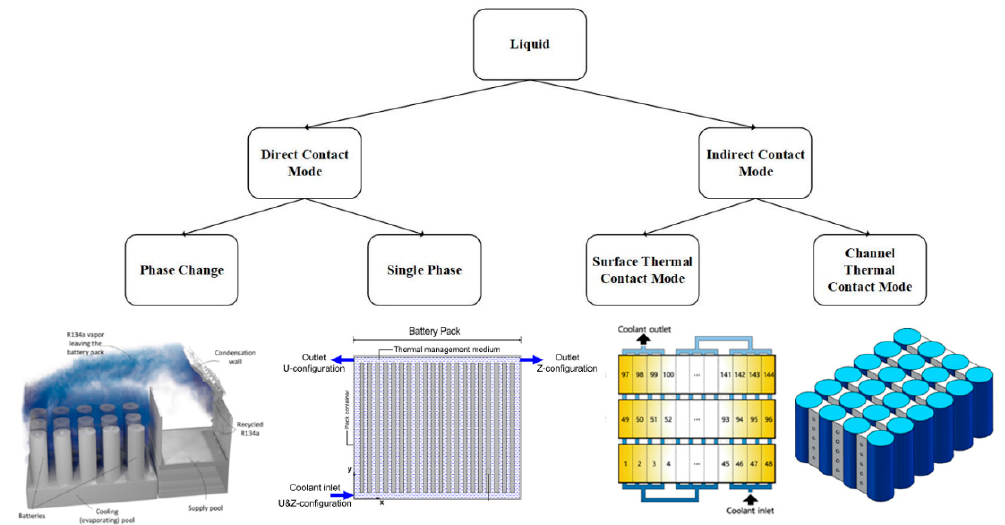
Figure 3. Classification of liquid cooling and corresponding classic examples [40–43].